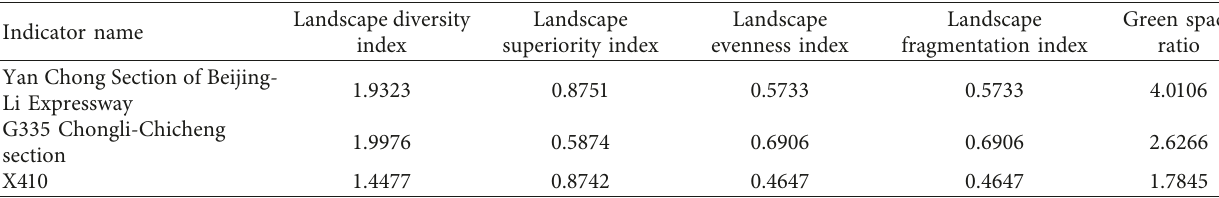
Table 7: Calculation results of ecological landscape index.